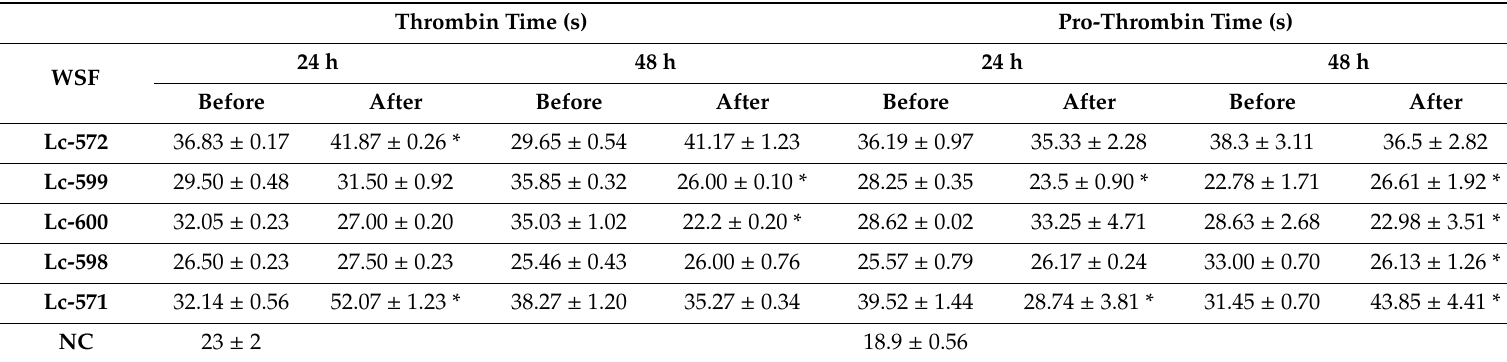
Table 2. Anticoagulant activity by thrombin time (s) and pro-thrombin time (s) on the plasma of water soluble fraction (WSF) from fermented milk with L. lactis with 24 or 48 h of fermentation, before and after simulated gastrointestinal digestion (SGD).